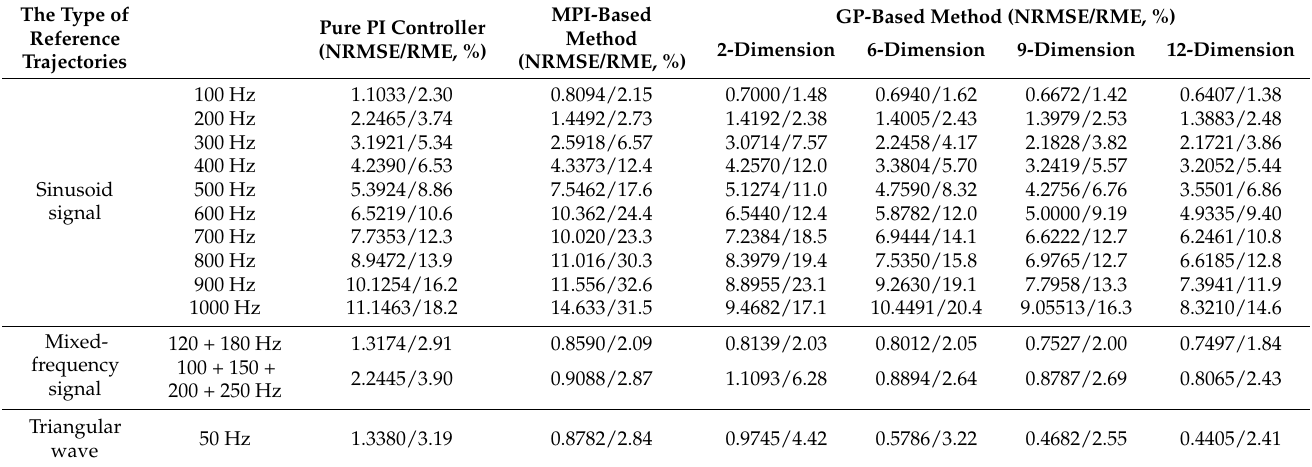
Table 3. Tracking results of the closed-loop